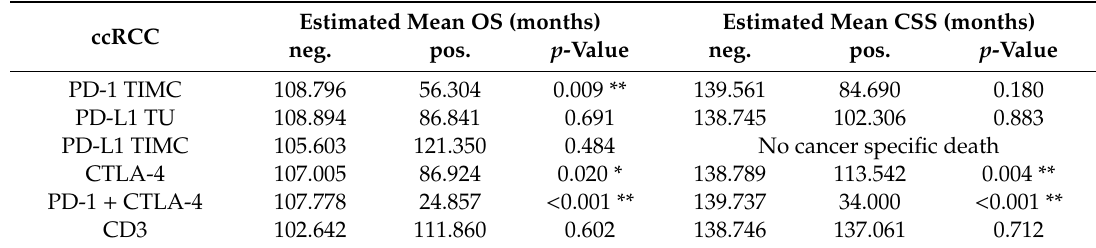
Figure 6. Kaplan Meier analysis: Association of combined PD-1 and CTLA-4 expression with OS in all RCC patients.